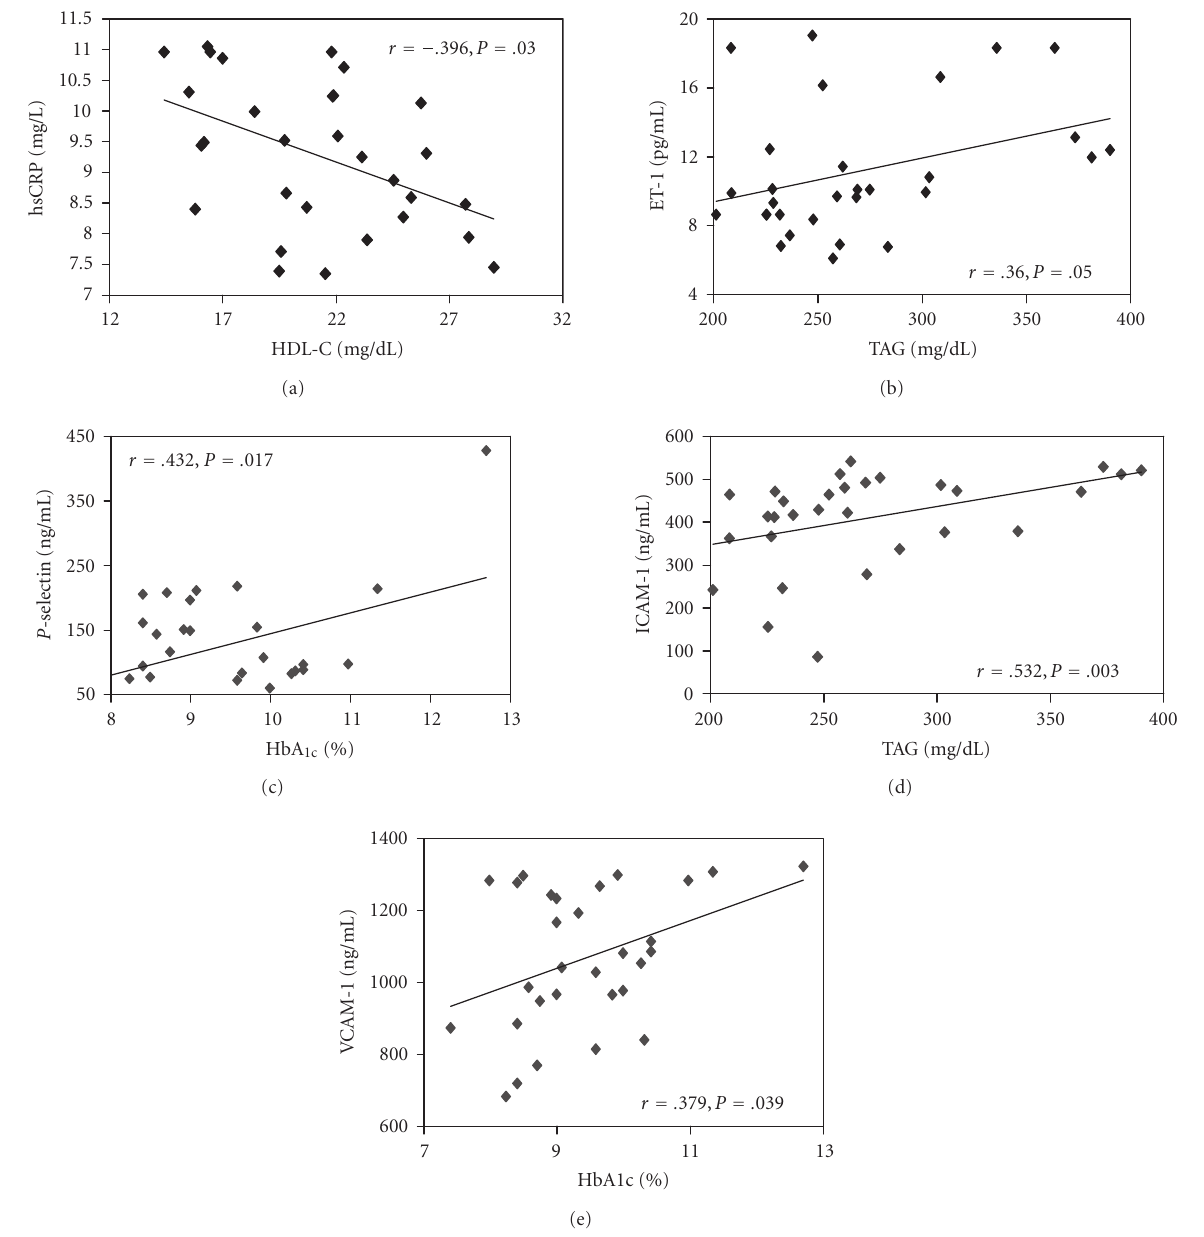
Figure 1: Correlation between (a) hsCRP (mg/L) and HDL-C (mg/dL), (b) ET-1 (pg/mL) and TAG (mg/dL), (c) P -selectin (ng/mL) and HbA 1c (%), (d) ICAM-1 (ng/mL) and TAG (mg/dL), and (e) VCAM-1 (ng/mL) and HbA 1c (%) in type 2 DM patients (groups III and IV) ( n = 30). Each individual value is represented by a symbol ( (cid:2) ), r = Spearman’s rank correlation coe ffi